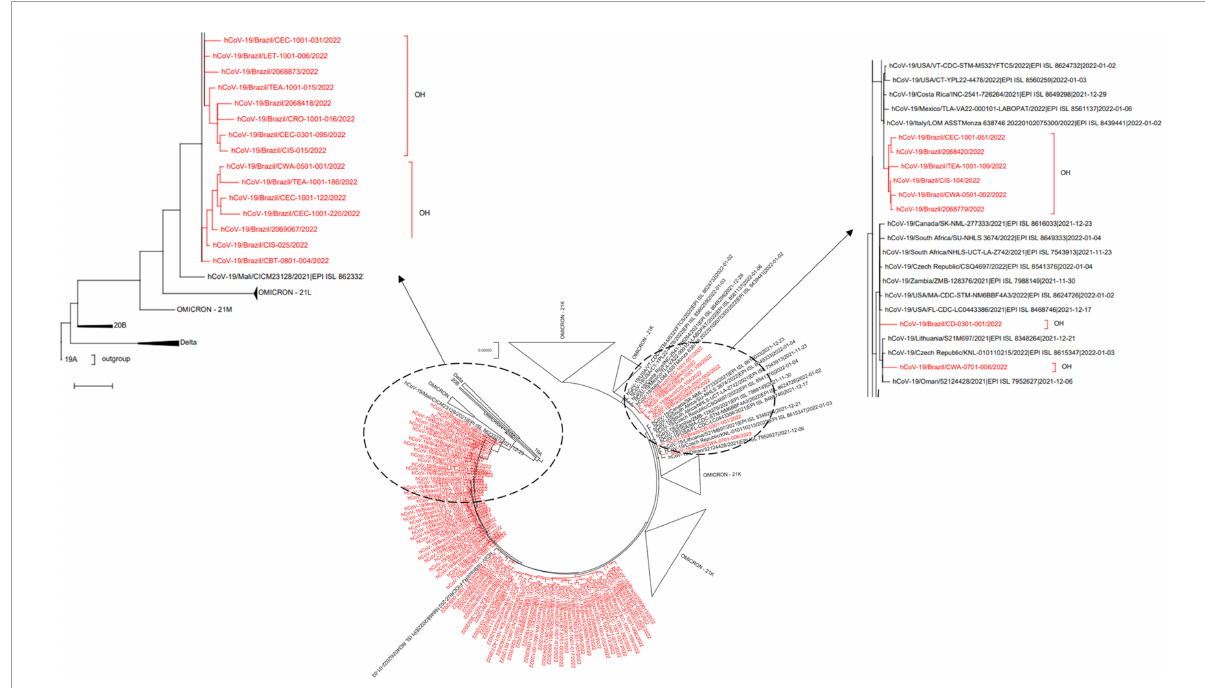
FIGURE3 SARS-CoV-2 phylogeny reveals multiple introductions of Omicron VoC in Rio de Janeiro. The genome consensus sequences isolated in this study were compared to Omicron correlates deposited at GISAID (https://www.gisaid.org; Supplementary datasheet 1 ), using a